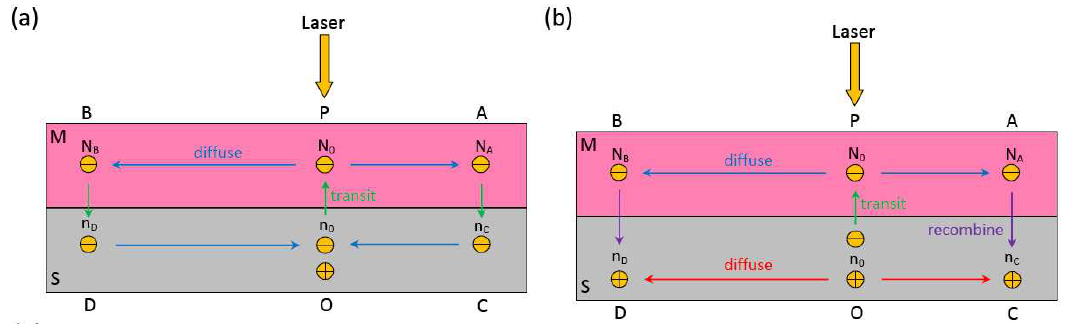
Figure 12. Diagram of carrier diffusion in MS structure induced by laser illumination.